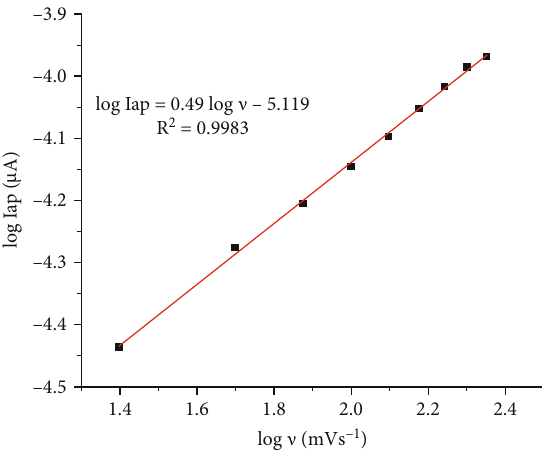
Figure 4: A plot of log Iap (anodic peak current) vs. log ν (scan rate). Other parameters are the same as in Figure 3.